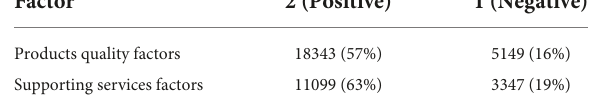
TABLE 2 Analysis of the emotional polarity of online reviews under different factors. Factor 2 (Positive) 1 (Negative) Products quality factors 18343 (57%) 5149 (16%) Supporting services